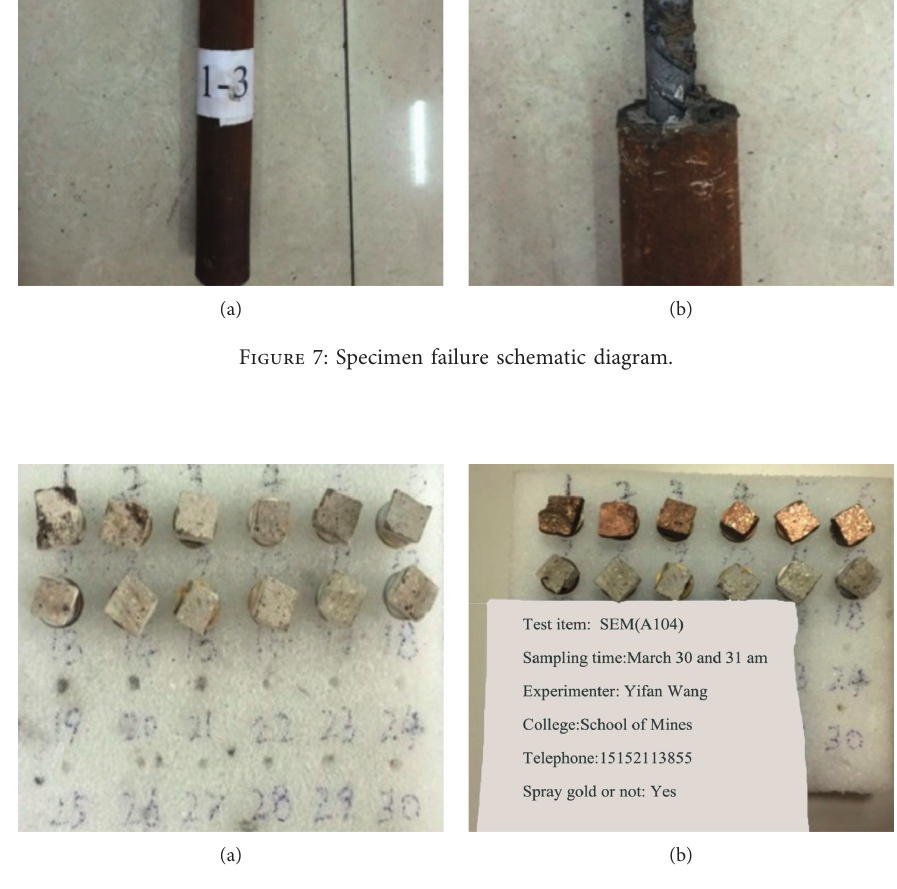
Figure 8: Gold spraying treatment of